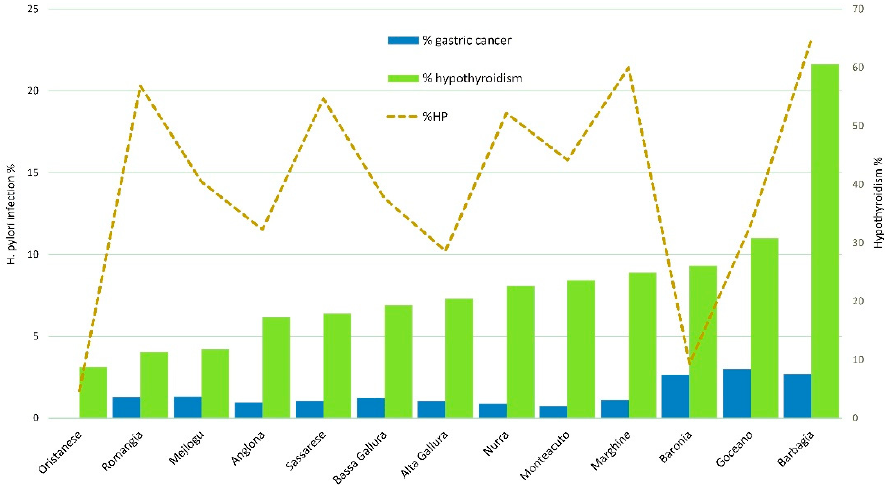
Figure 3. Distribution of hypothyroidism, gastric cancer, and H. pylori infection across Sardinian historical subregions.